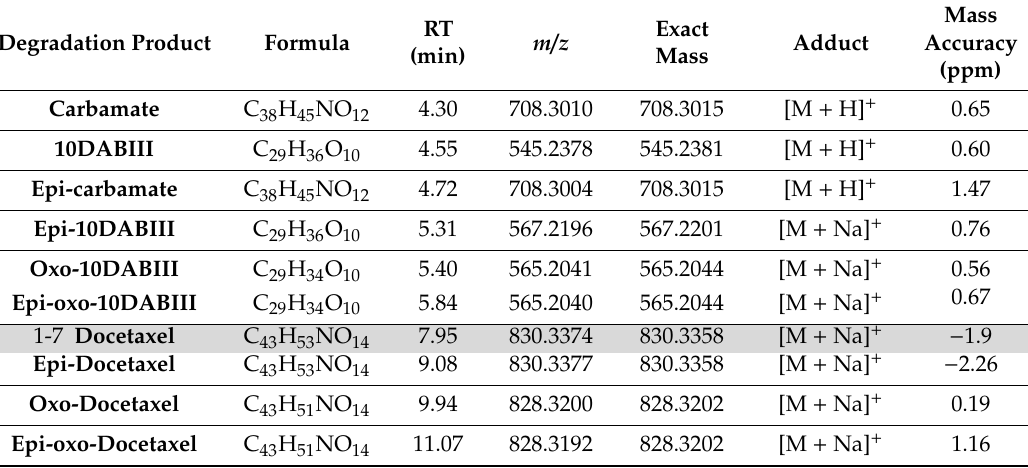
Table 2. LC-MS data of docetaxel (highlighted gray) and postulated degradation products, acquired using method